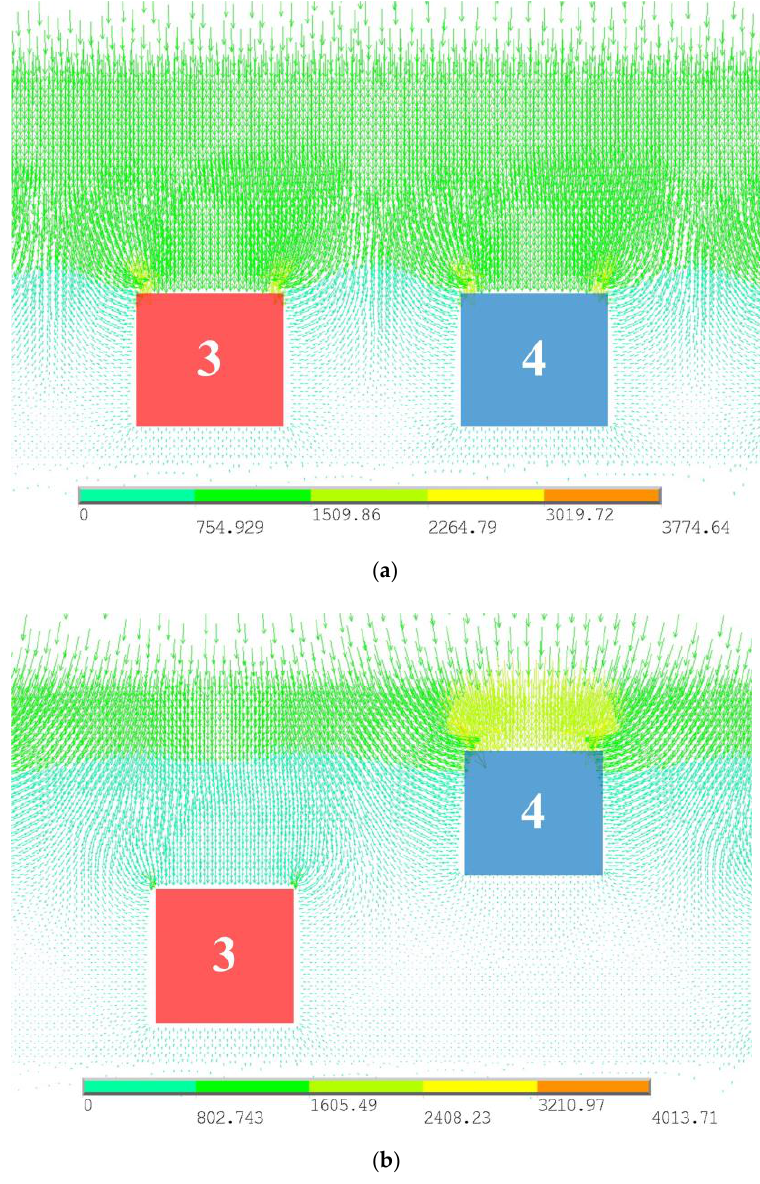
Figure 6. Vector-graph of e lectric field distribution at the electrodes. ( a ) Stationary state. ( b ) Mov- ing